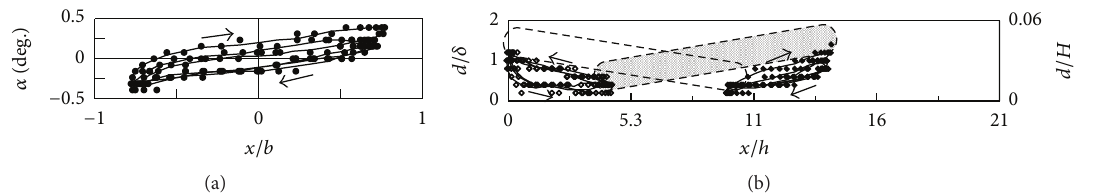
Figure 7: The change ot the body angle (a) and dimensionless gap (b) during the oscillations.